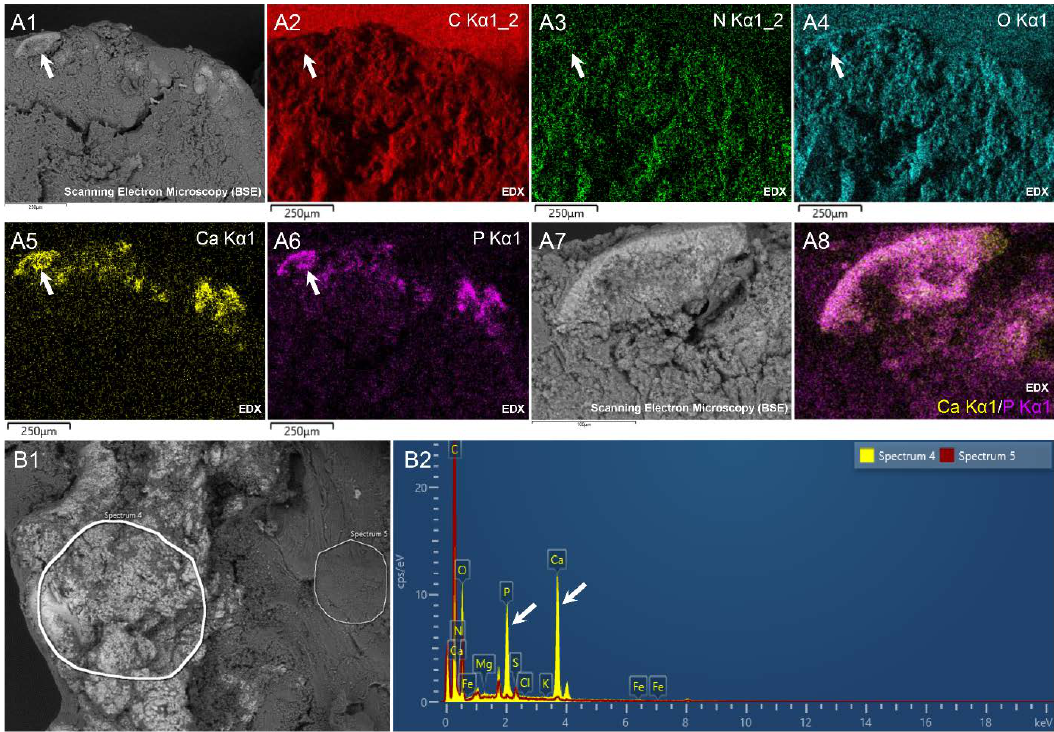
Figure 6. Scanning electron microscopy coupled to energy-dispersive X-ray (EDX) spectroscopy of a bright region from S. oralis and S. gallolyticus infected vegetation. ( A ) S. oralis vegetation with bright regions. ( A1 ) SEM view. ( A2 – A6 ) Multi-element EDX mapping images of C, N, O, Ca and P. ( A7 ) High magnification view by SEM of the region depicted in ( A1 – A6 ) (arrow). ( A8 ) Colocalization of Ca and P-EDX map of the same region as in ( A7 ). ( B ) S. gallolyticus vegetation. ( B1 ) SEM image with large bright regions. ( B2 ) EDX spectra of the two regions circled in ( B1 ), showing the higher amount of P and Ca for spectrum 4 compared to spectrum 5. Table 3. Results (mean ± SD) of weight and atomic percentages of C, O, N, P, Ca in the bright and non-bright regions of the S. gallolyticus vegetation. ** p < 0.01; *** p < 0.001. C O N Ca P Non-bright regions Weight %